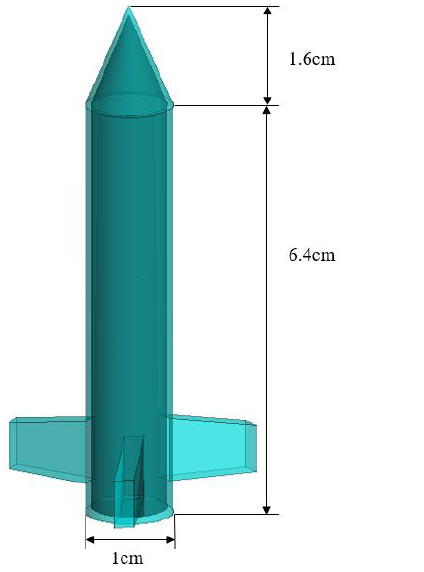
Figure 14. The geometry of the coated missile.